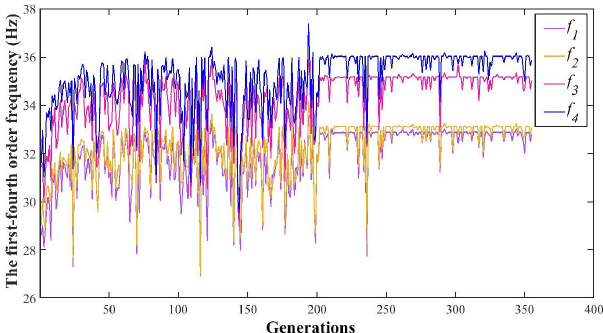
Figure 20. Variations of the first- to fourth-order frequency changes under different numbers of generation.